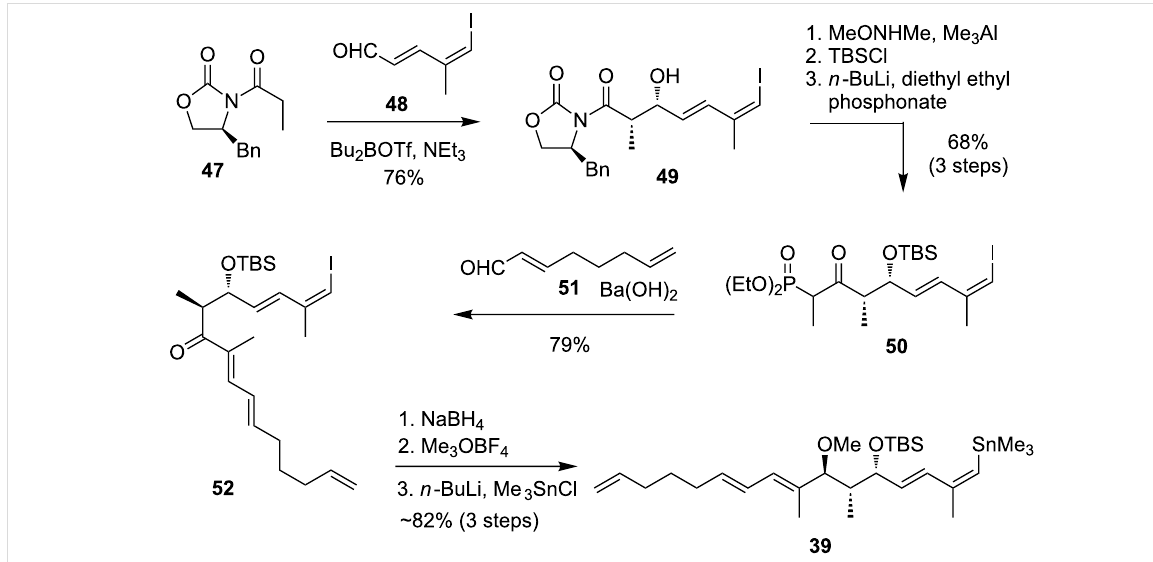
Scheme 10: Synthesis of precursor 39 for the projected relay RCM reaction.